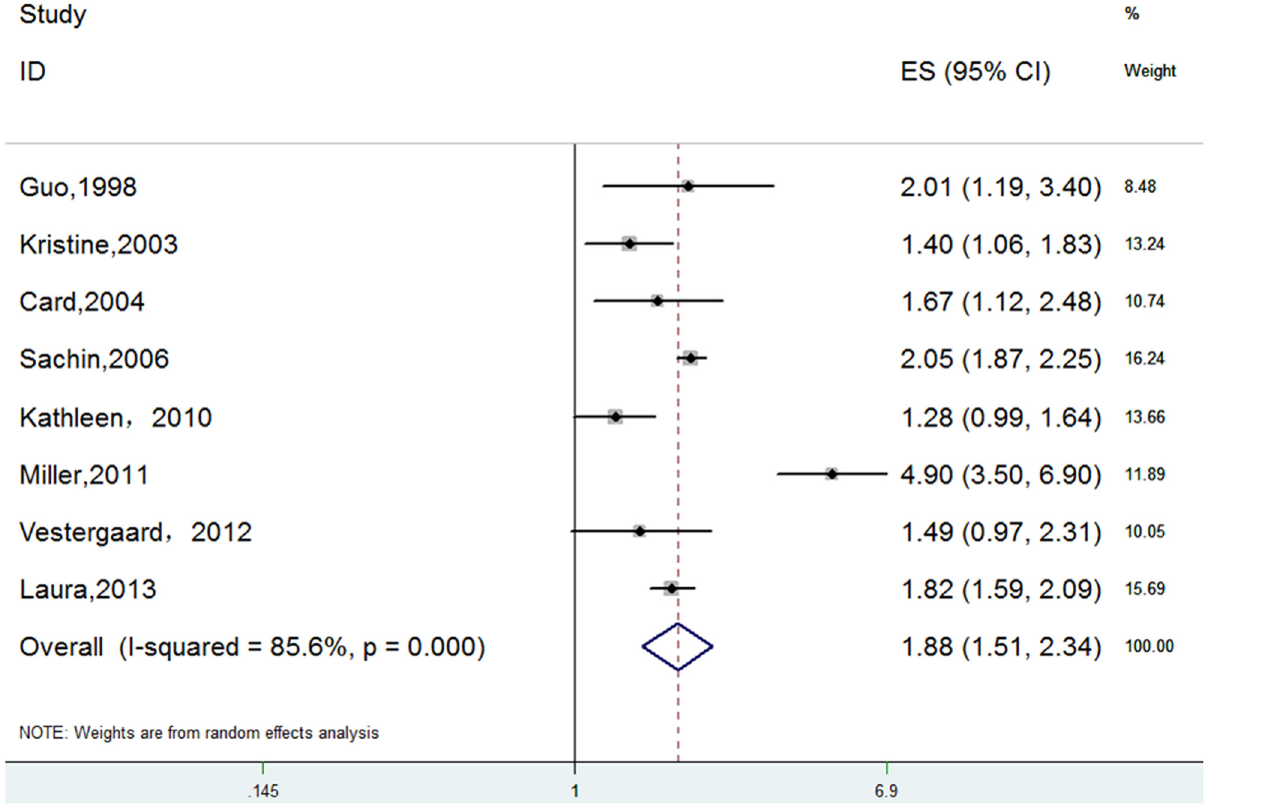
Fig 2. Forest Plot of RR with CI for Opioid Use and Fracture